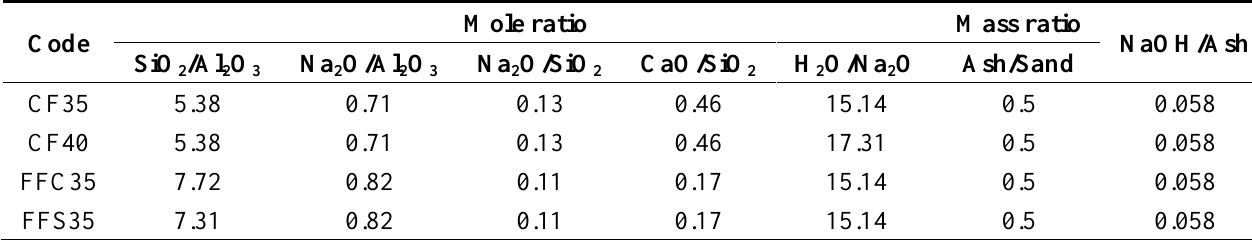
Table 2. Mix proportion of geopolymer